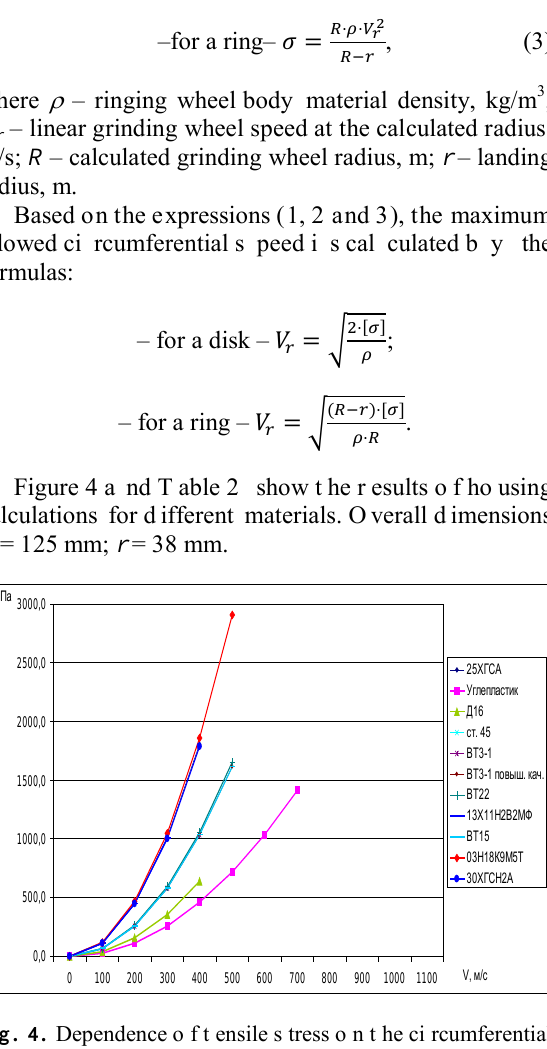
Fig. 2. Cut v oltage de pendence o n g rinding w heel circumferential speed.